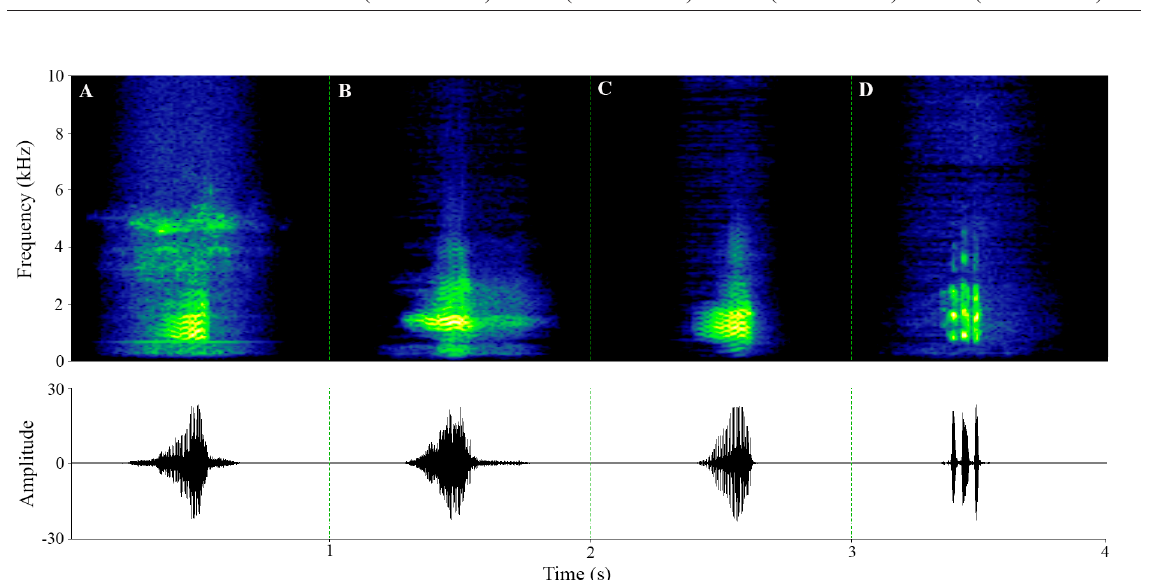
Fig. 5. Spectrogram (above) and oscillogram (below) of advertisement calls. A–C . Three populations of Physalaemus maculiventris (Lutz, 1925). A . Paranapiacaba (FNJV 31815). B . São Paulo (FNJV 31988). C . Salesópolis (FNJV 33756). – D . P. araxa sp. nov. from Ibitirama (FNJV